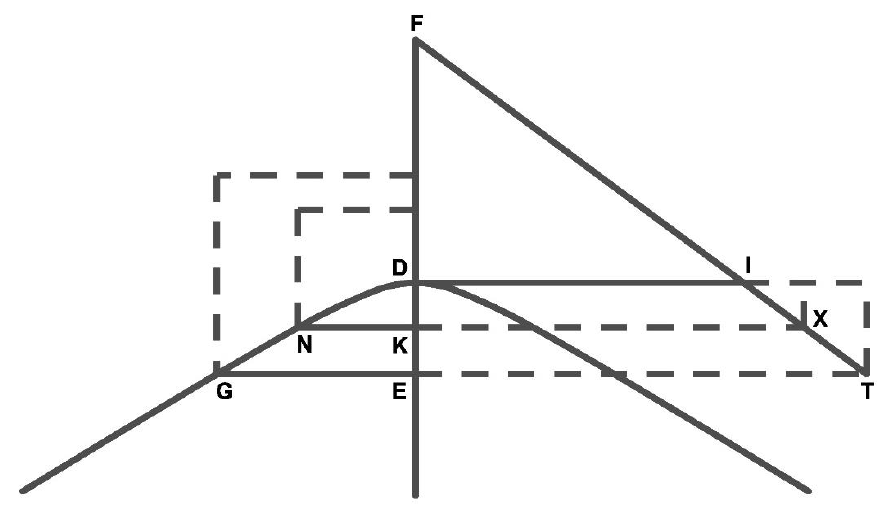
Figure 4. Hyperbola of vertex 𝐷 and transverse diameter 𝐹𝐷 as defined in prop. 1.13 in the text.